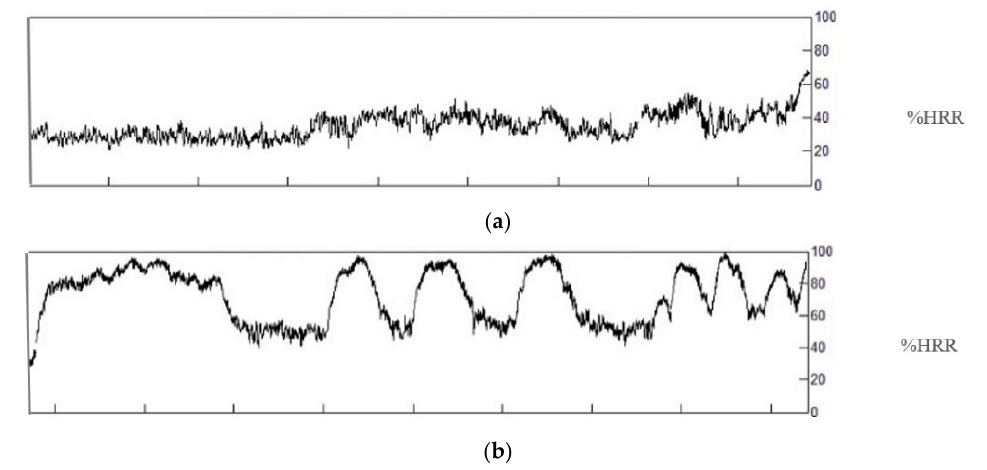
Figure 8. Representative example of one worker’s heart rate; ( a ) during the most active period on a regular day and; ( b ) during the three Goldilocks-games. Abbreviation: HRR, heart rate reserve.